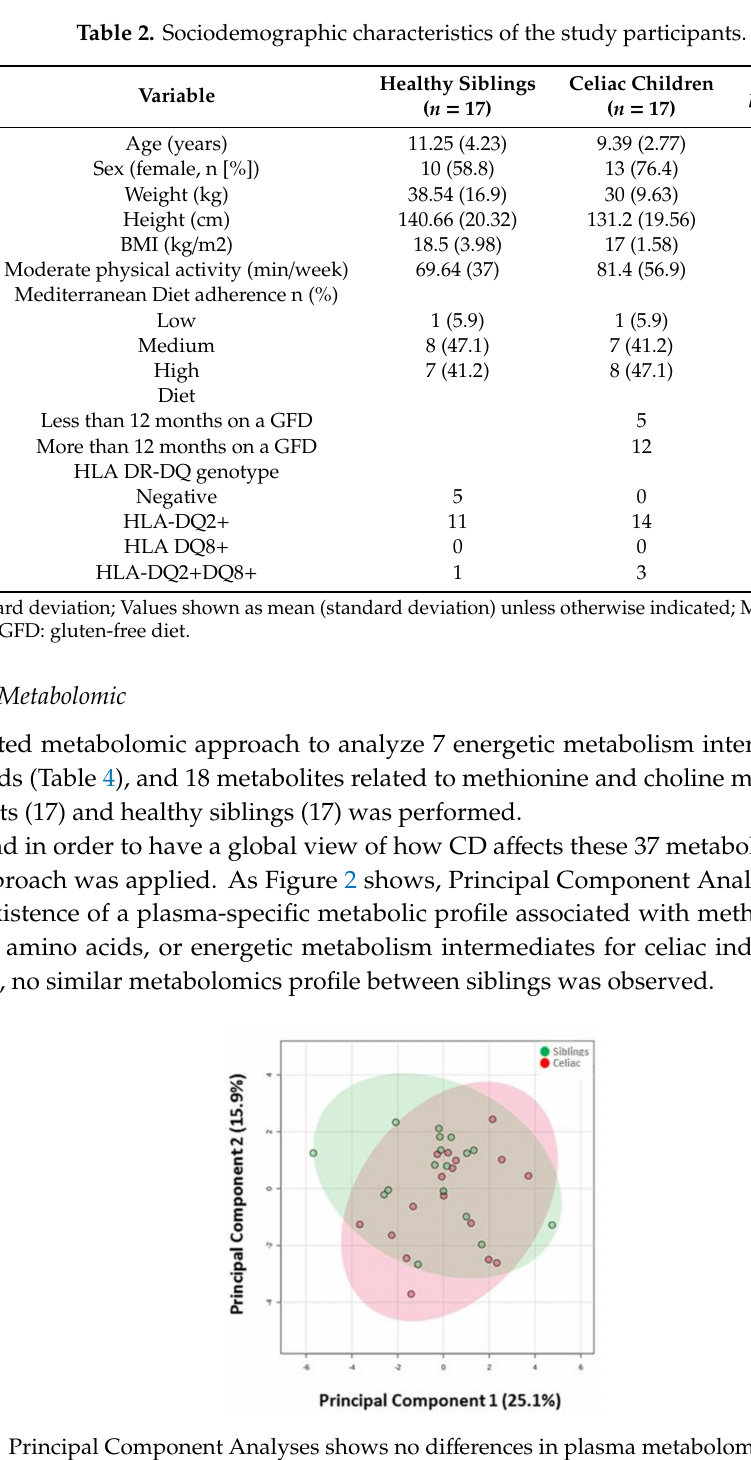
Figure 2. Principal Component Analyses shows no di ff erences in plasma metabolome of metabolites analyzed between celiac disease patients and healthy